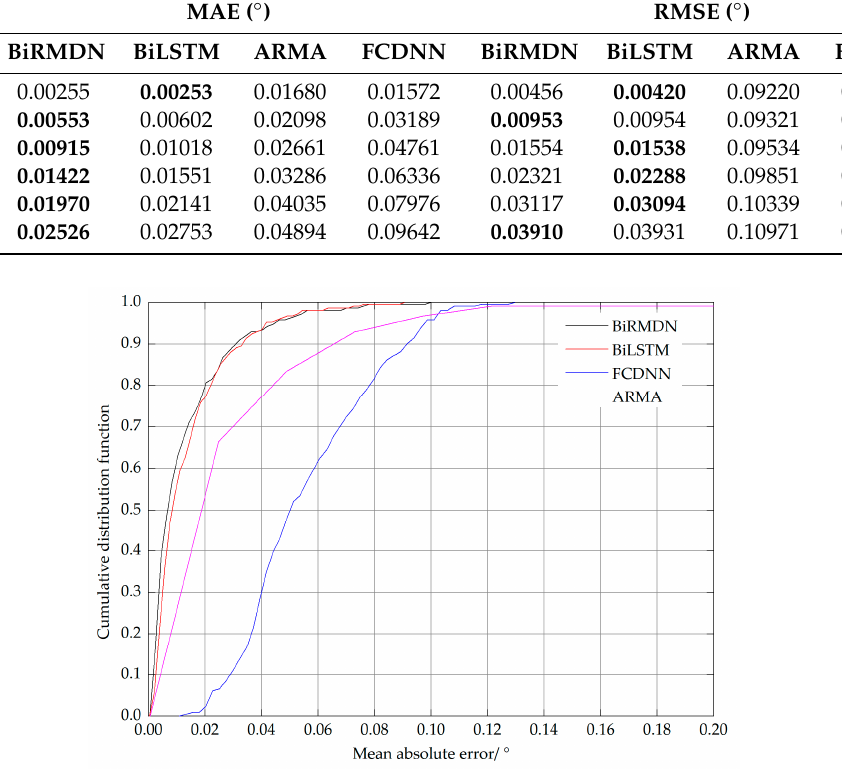
Figure 9. Cumulative distribution function (CDF) of the mean absolute error over six predicted